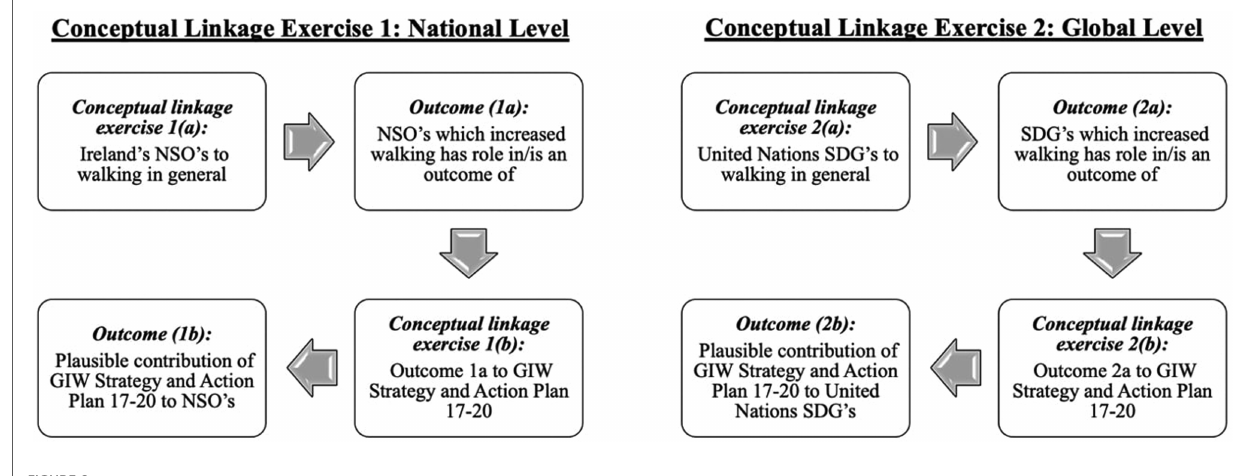
FIGURE 2 Conceptual linkage exercises work fl ow. (NSOs, National Strategic Outcomes; SDG ’ s, Sustainable Development